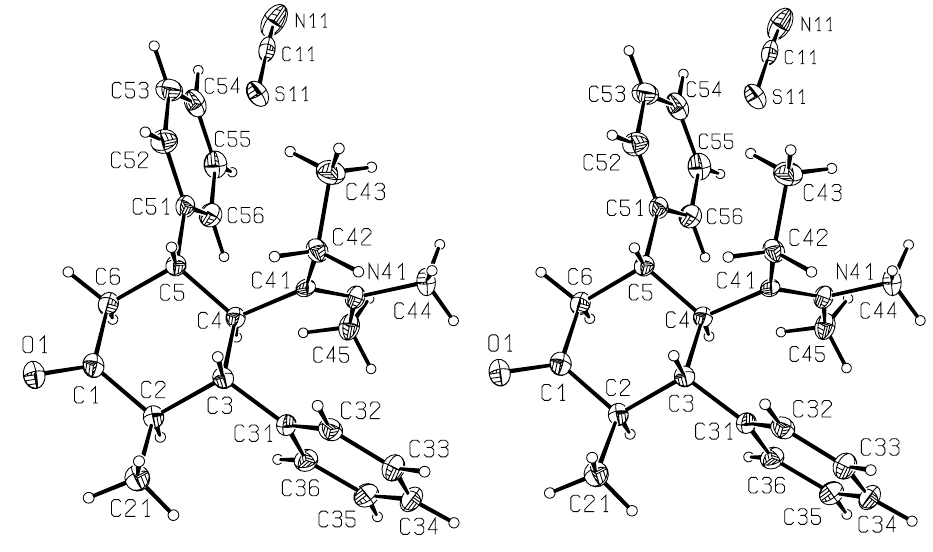
Figure 2 . Stereoscopic ORTEP [7] plot of 16 showing the atomic numbering scheme. The probability ellipsoids are drawn at the 50% probability level.